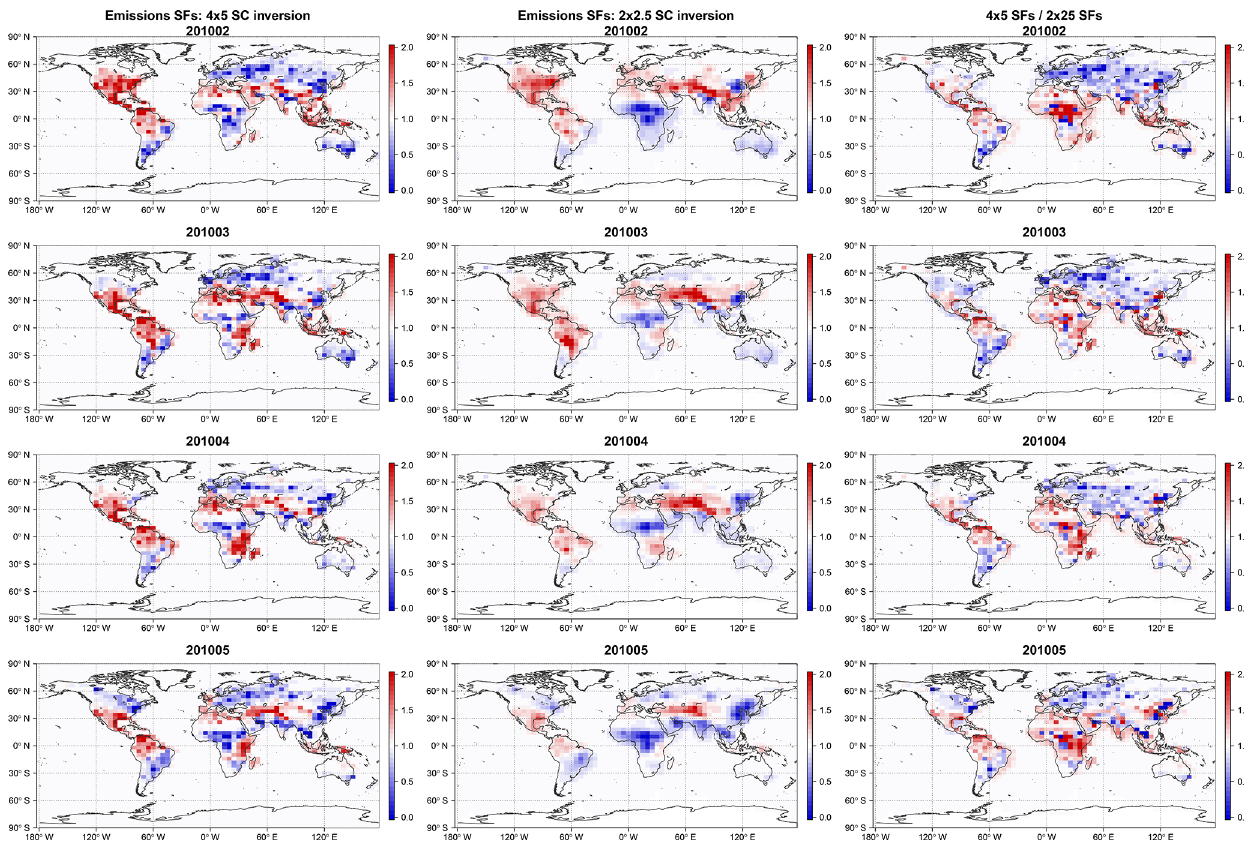
Figure 4. Monthly mean scaling factors (ratio of optimized to a priori CH 4 surface emissions). Shown are the scaling factors from the 4 ◦ × 5 ◦ (first column) and 2 ◦ × 2 . 5 ◦ (second column) assimilations. The third column shows the ratio of the 4 ◦ × 5 ◦ to 2 ◦ × 2 . 5 ◦ scaling factors. Results are shown for February (first row), March (second row), April (third row), and May (fourth row) 2010.